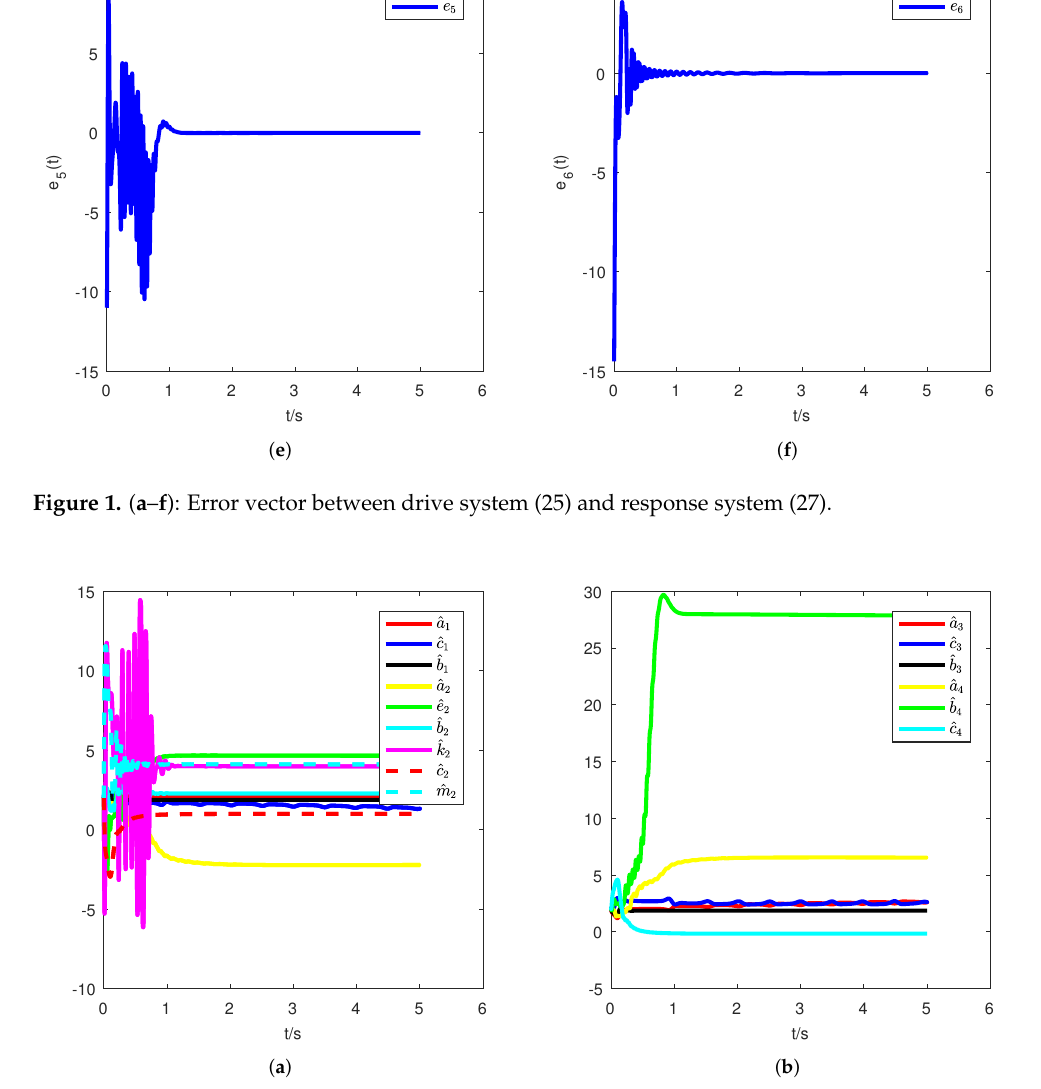
Figure 2. ( a , b ): Time response of estimated values of parameters ˆ a 1 , ˆ c 1 , ˆ b 1 , ˆ a 2 , ˆ e 2 , ˆ b 2 , ˆ k 2 , ˆ c 2 , ˆ m 2 of drive systems (25) ˆ a 3 , ˆ c 3 , ˆ b 3 , ˆ a 4 , ˆ b 4 , ˆ c 4 of response system